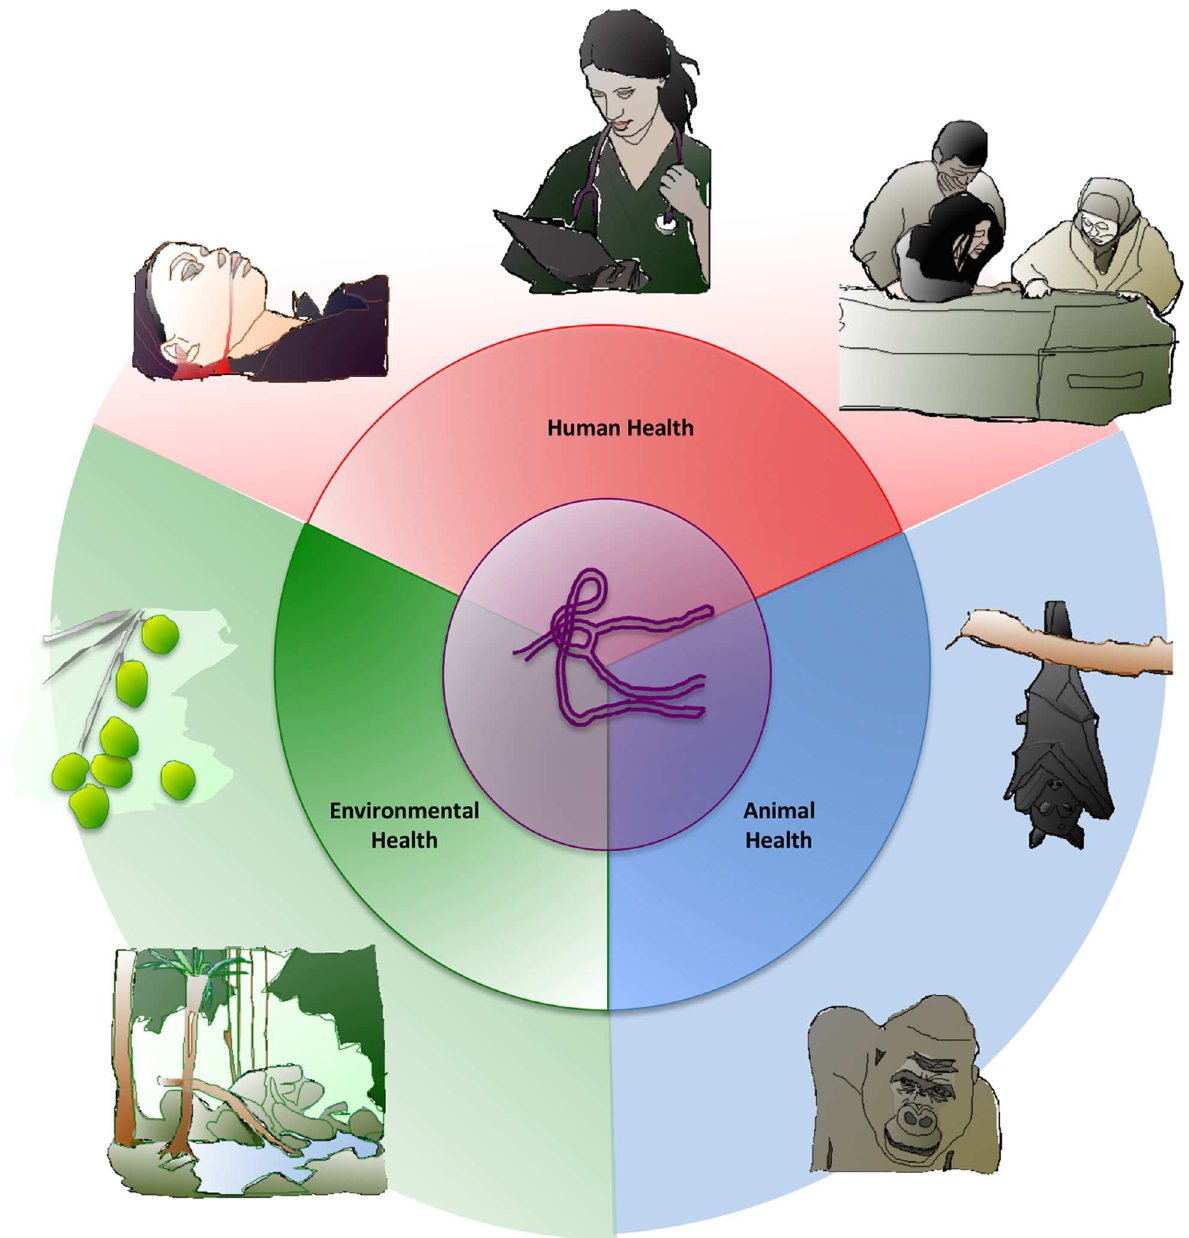
Fig 1. The One Health concept and components. The One Healthconceptallows for an emerginginfectious disease such as the Ebola epidemicto be viewed and addressedin a tripartite manner:factors fromhuman(pink),animal(blue) [52],and environmental (green)health are considered in the forecast and controlof